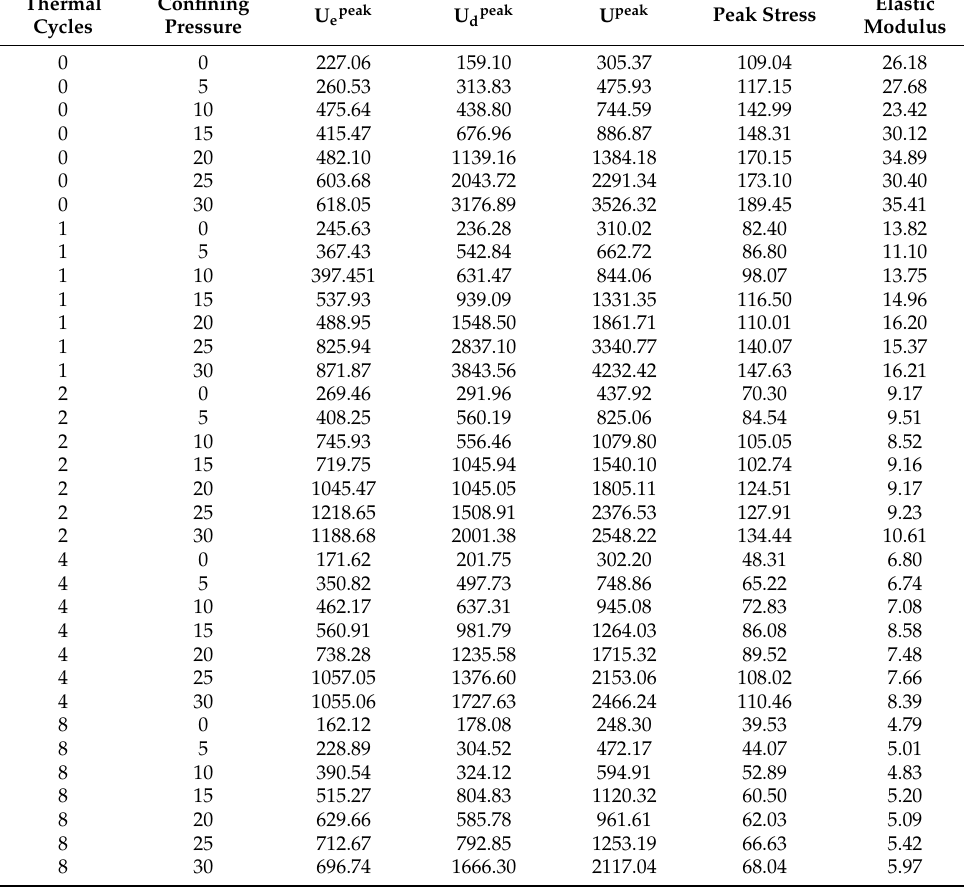
Table 3. Energy characteristic values of marble triaxial test under different numbers of thermal cycles. Thermal